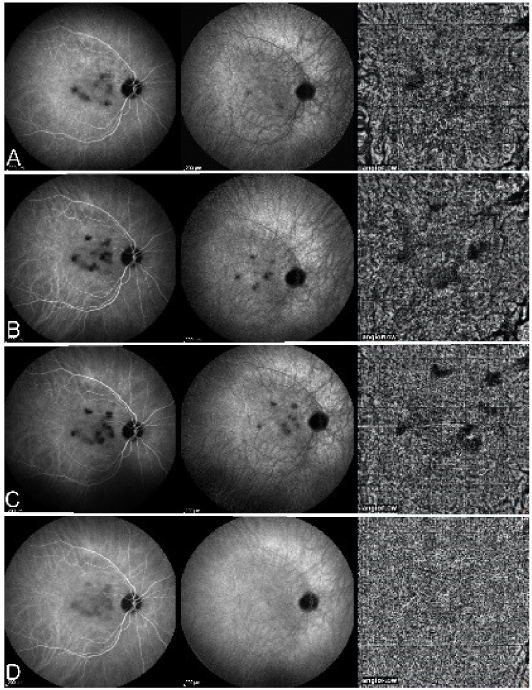
Figure 25. Serpiginous choroiditis—parallel images of intermediate phase ICGA (left column), late phase ICGA (middle column) and 6 × 6 mm OCT-Angiography (right column) of the right eye. ( A ). ICGA of the right eye reveals macular hypofluorescent lesions, increasing six months later ( B ), not responding to a Sub-Tenon’s injection ( C ), finally responding to the introduction of cyclosporine ( D ). (OCT-A pictures evolve in parallel with ICGA frames with faint dark areas visible at presentation (( A ), right), more clearly visible 6 months later (( B ), right) and three months after sub-Tenon’s injection (( C ), right) and disappearing three months after cyclosporine treatment ( D